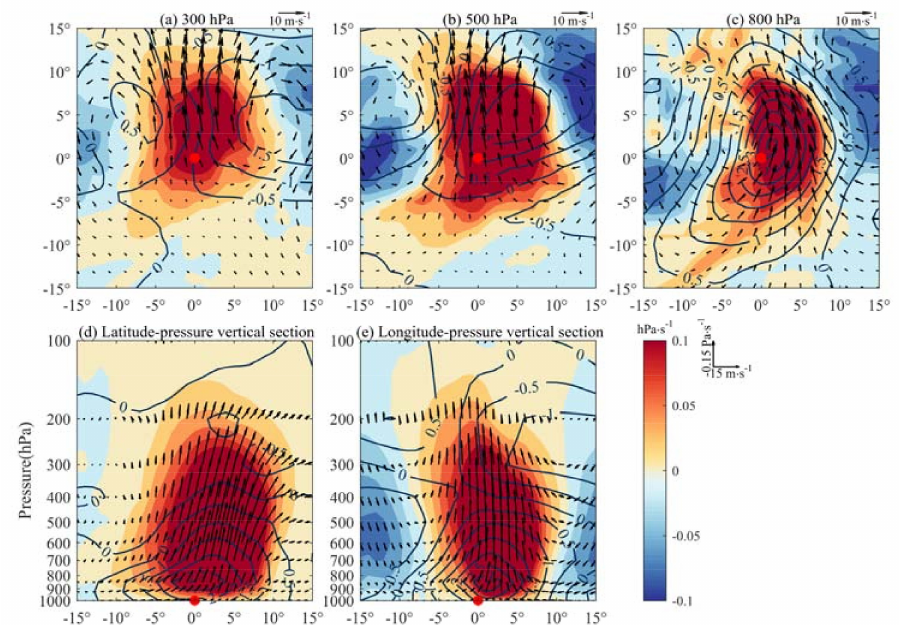
Figure 5. Composite horizontal distributions of wind vectors (black arrows, unit: m/s), wind speed (colored shading, unit: m/s), and temperature anomaly (black contours, unit: K) at the 300 hPa ( a ), 500 hPa ( b ) and 850 hPa ( c ), respectively, under the cyclone centered coordinate, and composite vertical sections of wind vectors (black arrows, horizontal speed unit: m/s; vertical speed unit: − 1 hPa/s), vertical wind speed (color shading, unit: − 1 hPa/s), and temperature anomaly (black contours, unit: K) along the 0 ◦ latitude ( d ) and 0 ◦ longitude ( e ) in the cyclone centered coordinate based on the selected cyclones in the Northwest Pacific. The red spot is the center of the extratropical cyclone at the sea